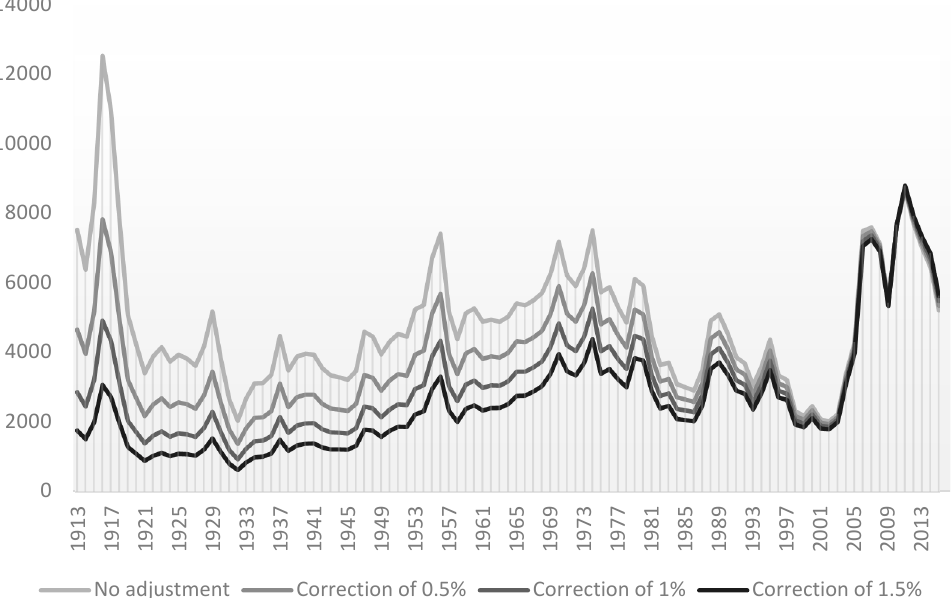
Figure 2. Annual copper real prices in cents per ton (cent/ton) from 1913 to 2015 (2010 = 100%).